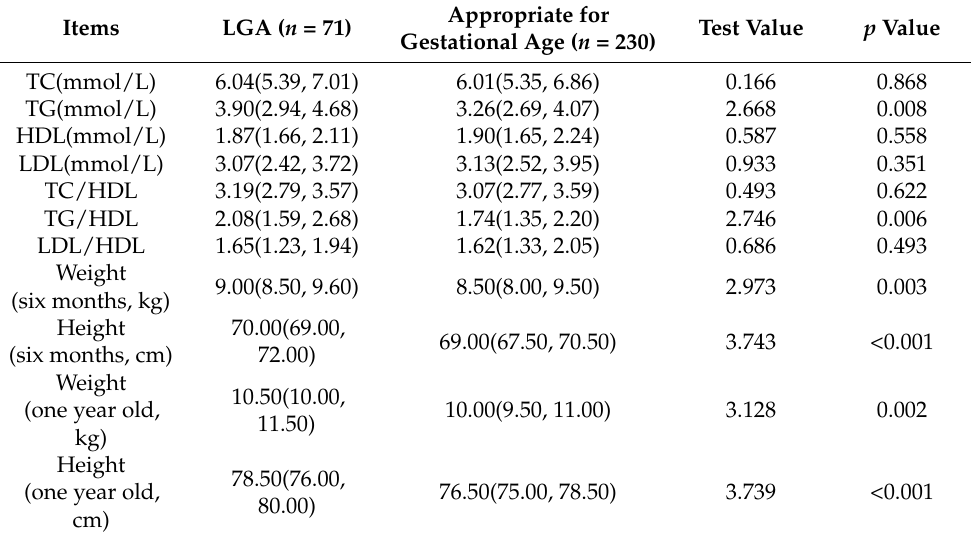
Table 3. Comparison of blood lipid levels of pregnant women and the weight and height of infants in LGA and appropriate for gestational age groups (median, quartiles).